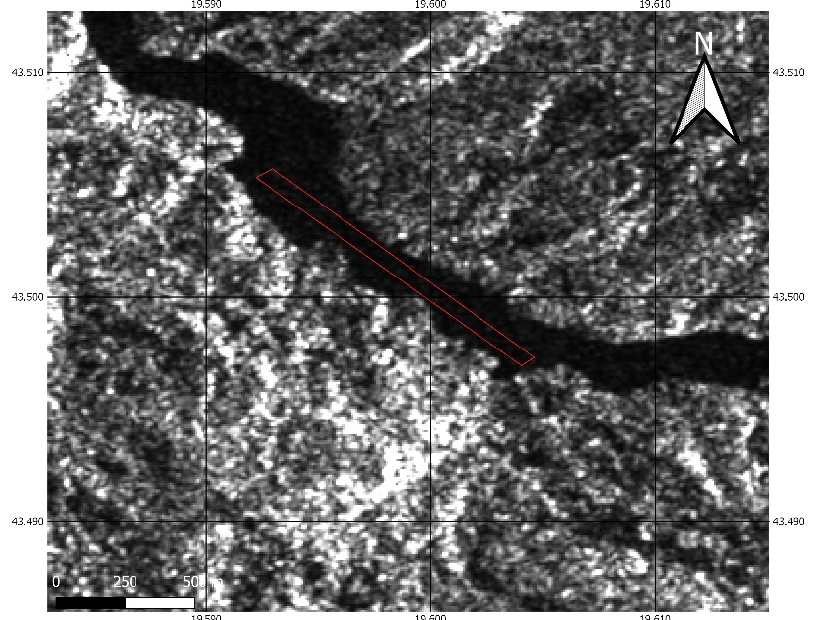
Figure 8. Mask of Clean region within Potpecko Lake, Serbia, 5 May 2020. The red polygon highlights the region used for the clean mask (Sentinel-1, Credits: